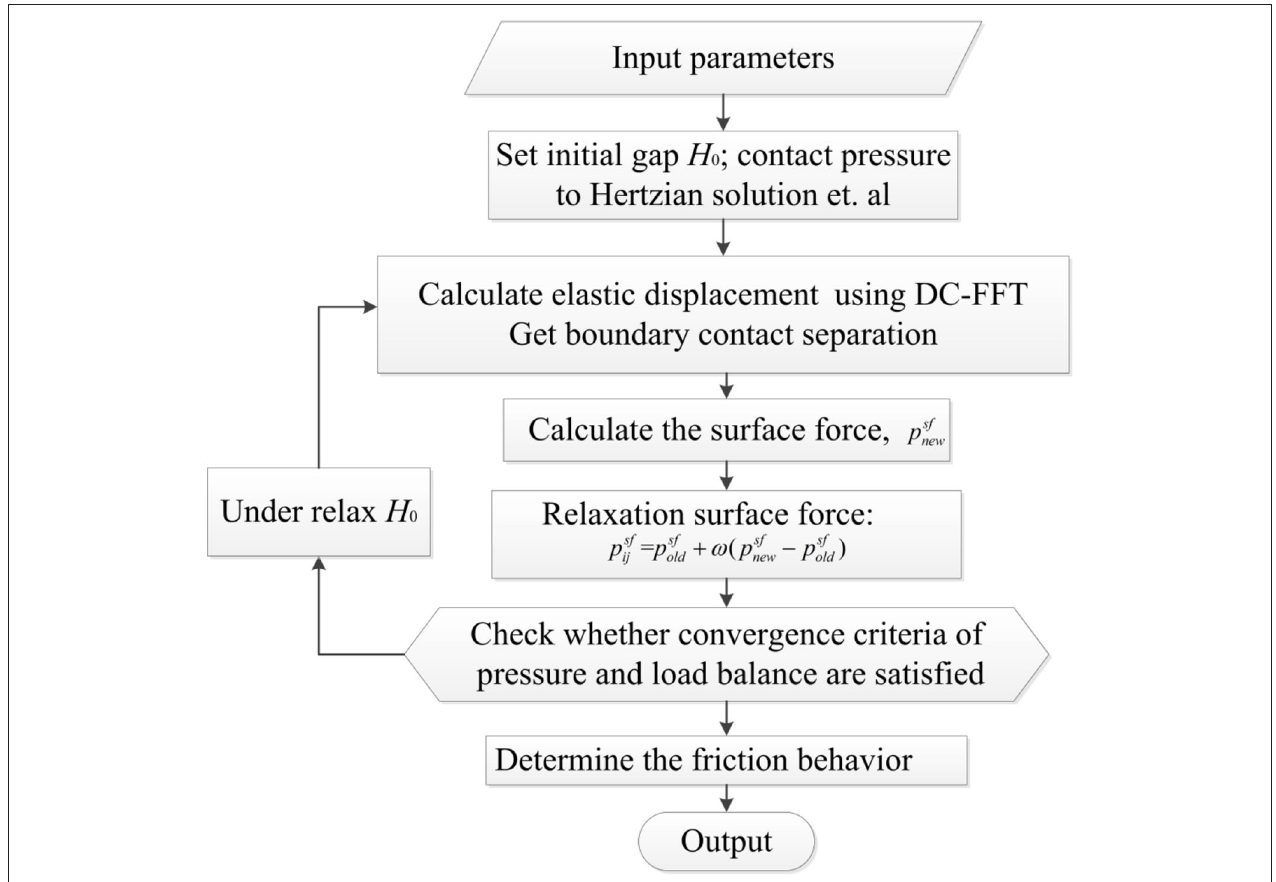
FIGURE 3 | Flow chart of the numerical